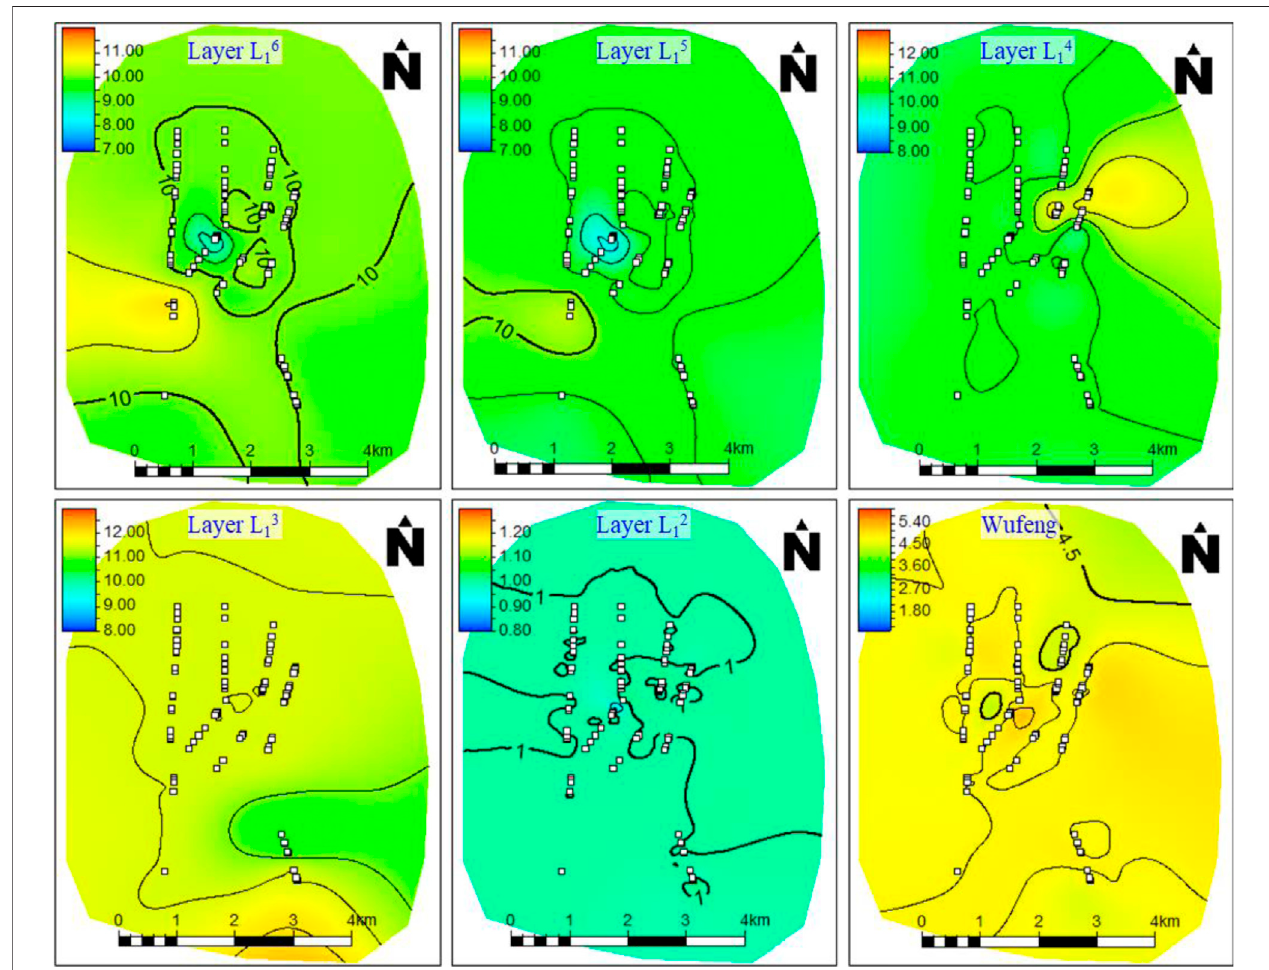
FIGURE 10 | Isopach maps of the six shale layers in the JY-1 district after adjusting their TVTs using dip angle change threshold of 2.5 ° and thickness change threshold of 10%. The white- fi lled squares represent the location of PVW-As.